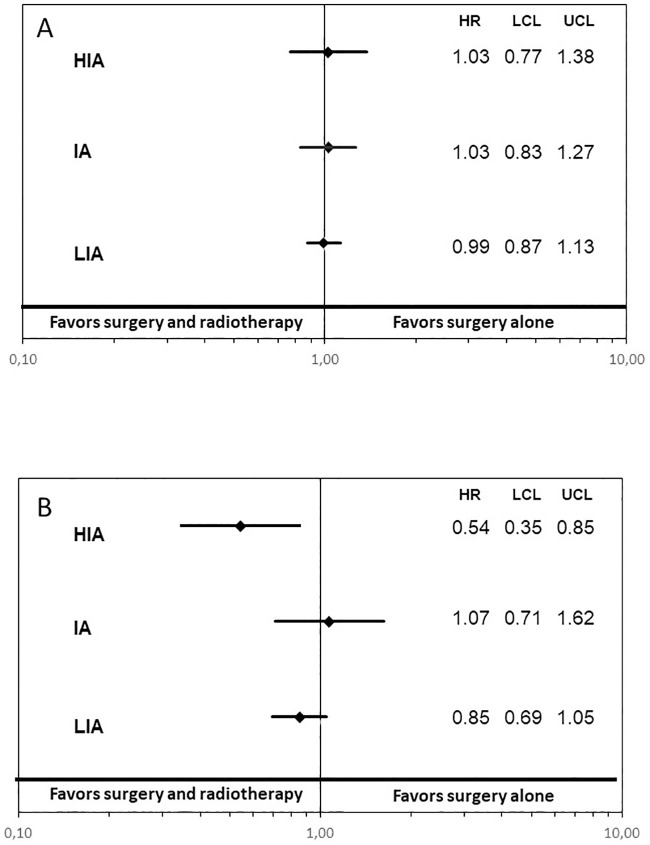
Impact of surgery with additional radiotherapy on mortality in the trend of interaction by treatment period in pN0 (A) and N1 (B) situations.HR = hazard ratio; LCL = lower confidence level; UCL = upper confidence level; LIA = low IMRT availability period; IA = intermediate IMRT availability period; HIA = high IMRT availability period.